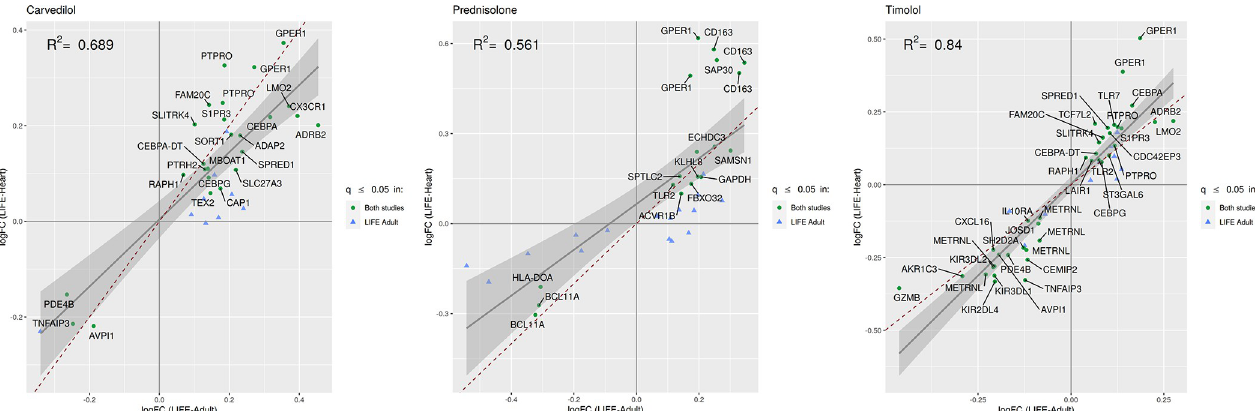
Fig 3. Differential gene expression caused by carvedilol, prednisolone and Timolol. Original results as obtained from LIFE-Adult and successfully replicated in LIFE-Heart. Genes may be captured on multiple probes and are then shown multiple times. All replicated genes show the same effect direction.